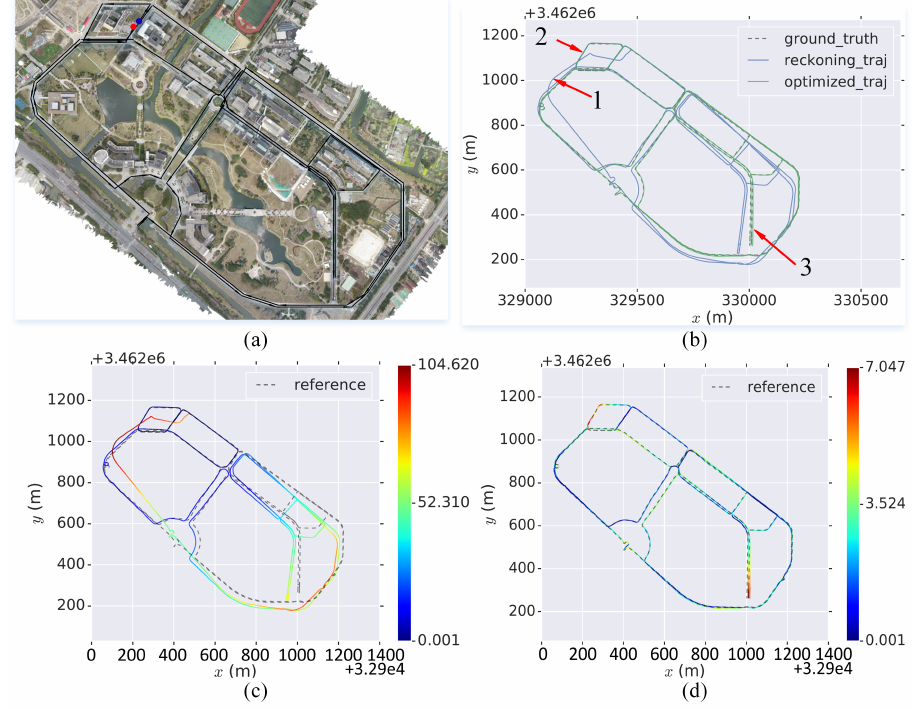
Figure 14. The evaluation of the resulting trajectory. ( a ) the data collection path where the blue dot indicates the start and the red dot indicates the end. ( b ) comparison of the ground truth, the reckoning-based trajectory, and the optimized trajectory. ( c ) the absolute positioning error of the reckoning-based trajectory. ( d ) the absolute positioning error of the optimized